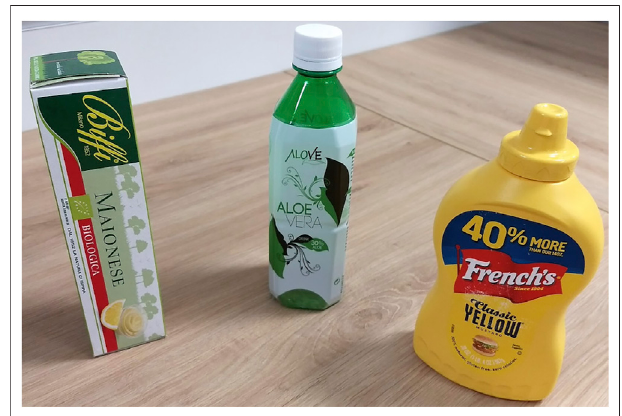
FIGURE6| Pictureoftheobjectsused intheexperiments. Fromtheleft, the box-shaped object, the water bottle and the mustard